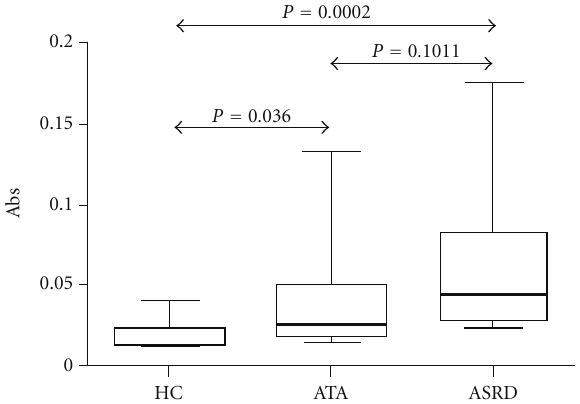
Figure 3: Comparison of galectin-10 levels before (b) and after (a) nasal challenge with L-ASA in nasal fluid lavage of aspirin-sensitive respiratory disease patients (ASRD), aspirin-tolerant asthmatics (ATA) and healthy controls